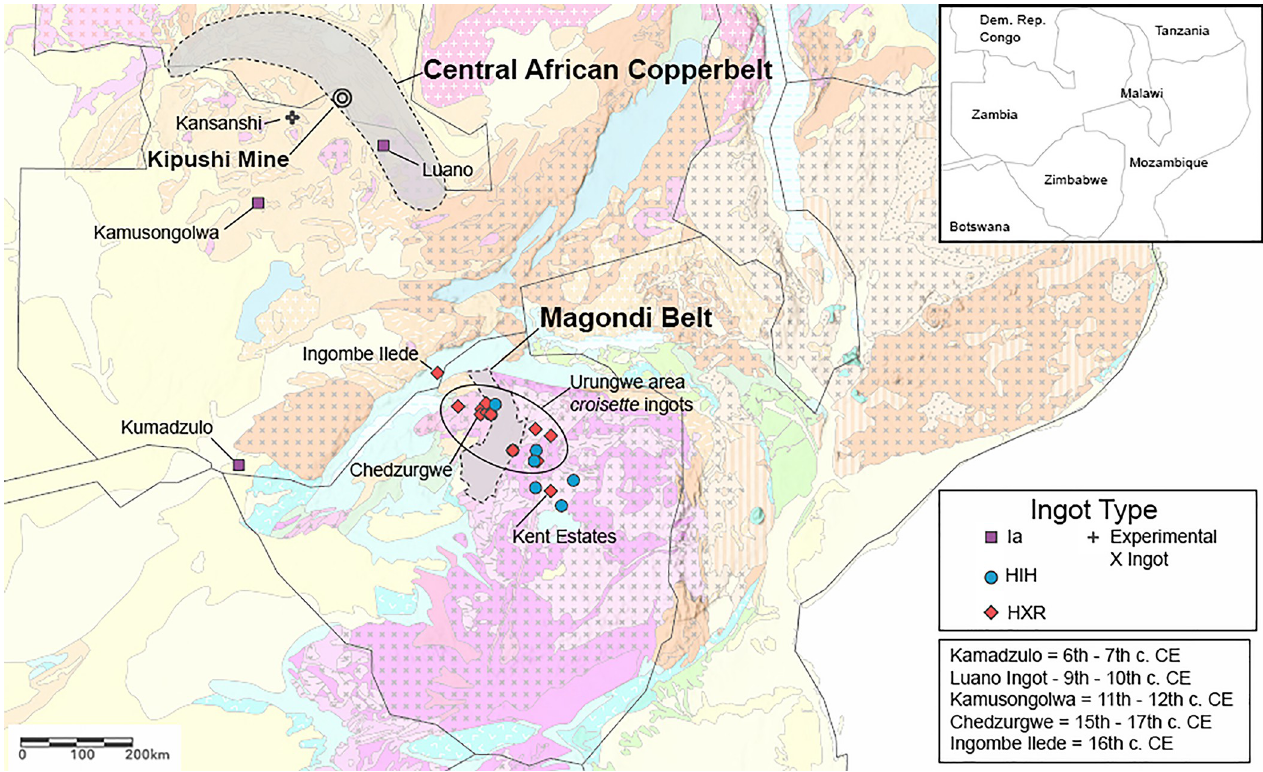
Fig 3. Highlighted archaeological sites, geological districts, and geological mines from the text. Geological basemap adapted from Thie´blemont et al. [20].